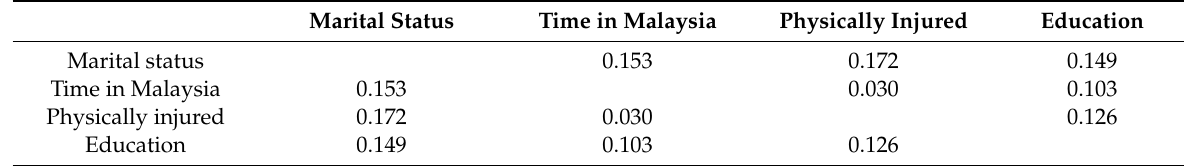
Table A2. Testing for multicollinearity among the independent variables significant at 0.25 in the univariate analysis examining the factors associated with GAD. Marital Status Time in Malaysia Physically Injured Education Marital status